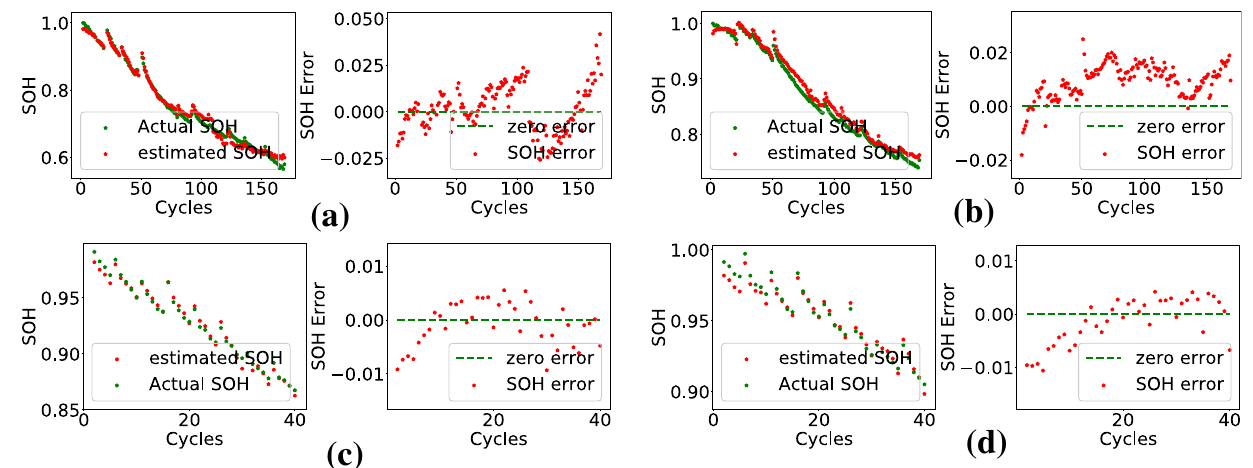
Figure 8. Plots of actual and estimated SOH, and error ( a ) B06, ( b ) B07, ( c ) B29, ( d ) B31 of NASA dataset.